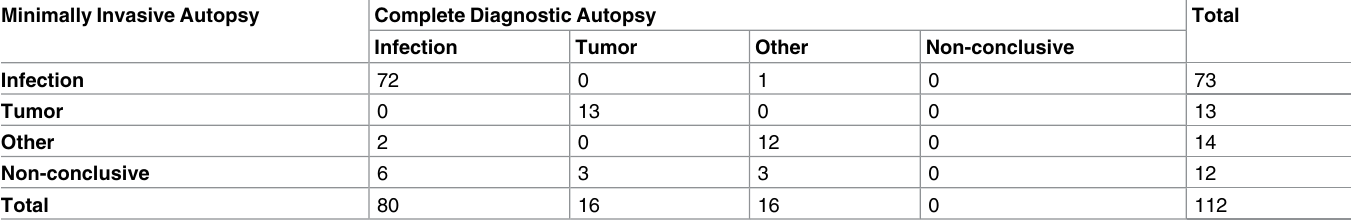
Table 5. Correlation between the minimally invasive autopsy diagnosis and the complete diagnostic autopsy diagnosis of all cases, grouped according to the major disease